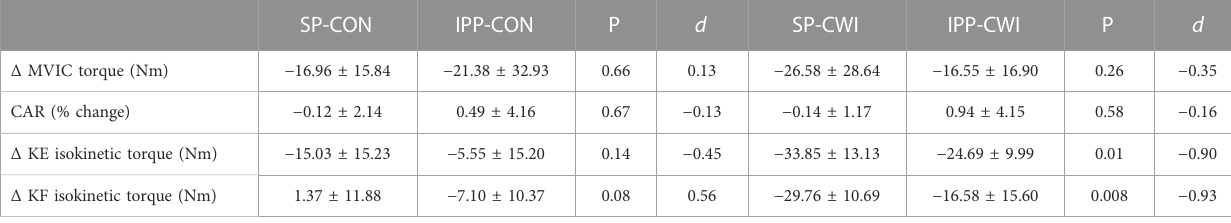
TABLE 4 Changes in maximal voluntary contraction torques and central activation ratio in the unfatigued